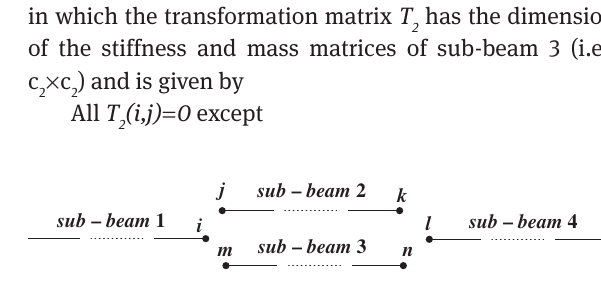
Figure 4 Nodes at the delamination